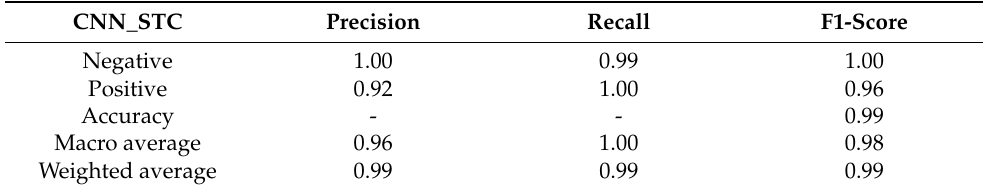
Table 3. Confusion matrix obtained by CNN on STC